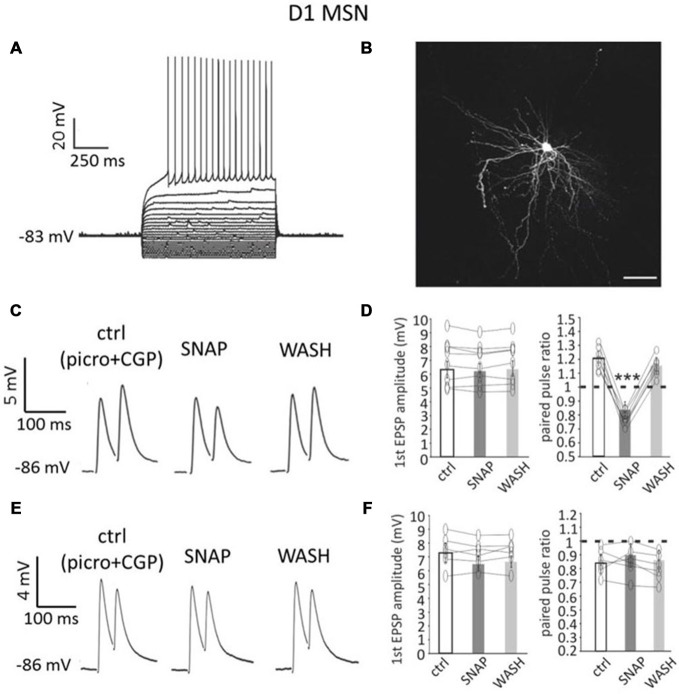
Paired pulse facilitation in D1-MSNs is converted into paired-pulse depression by SNAP. (A) A D1-MSN displayed typical electrophysiological properties when injected with current steps (20 pA increments). Rheobase current was 220 pA. (B) Neurobiotin staining of the neuron in A revealed dense dendritic arborizations and dendritic spines. Scale bar = 50 μm. (C) In a D1-MSNs, paired-pulse facilitation (at 50 ms interval) was observed in control solution (which contained GABAA and GABAB receptor antagonists), but was converted into paired-pulse depression by SNAP, that reduced the amplitude of the second evoked EPSP. These effects were reversed after SNAP washout. Each trace in this and subsequent figures showing paired pulse responses is the average of at least 50 consecutive responses. (D) Effects of SNAP on the first evoked response and the paired-pulse ratio of D1-MSNs that displayed paired-pulse facilitation in control solution. In this and in the following figures, asterisks indicate that the effects of certain treatment were statistical significant (*p < 0.05 and ***p < 0.001) in every cell tested. (E) In another D1-MSN, paired-pulse depression of corticostriatal responses was present in control solution. In this case, application of SNAP failed to significantly affect these responses. (F) Effects of SNAP on the first evoked response and the paired-pulse ratio of D1-MSNs that displayed paired-pulse depression in control solution.